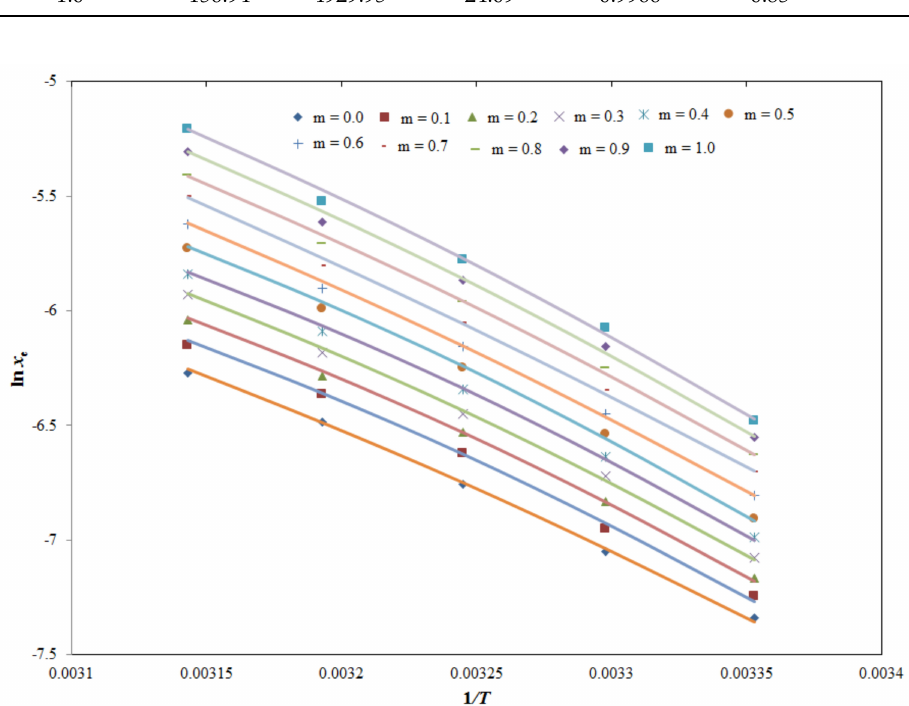
Figure 4. Graphical correlation of TQ solubility with the modified Apelblat model in various (IPA + H 2 O) mixtures at 298.2–318.2 K (the modified Apelblat solubility of TQ is indicated by solid lines, and experimental solubility of TQ is shown by the